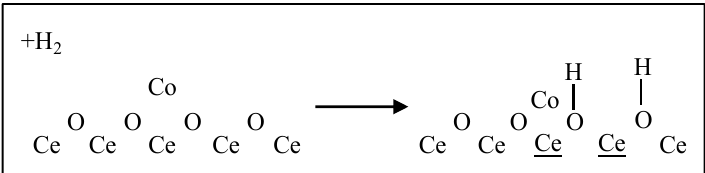
Figure 53. Bridging OH groups created in Ce due to addition of H 2 during the reduction process; ceria is a well-known partially reducible oxide.